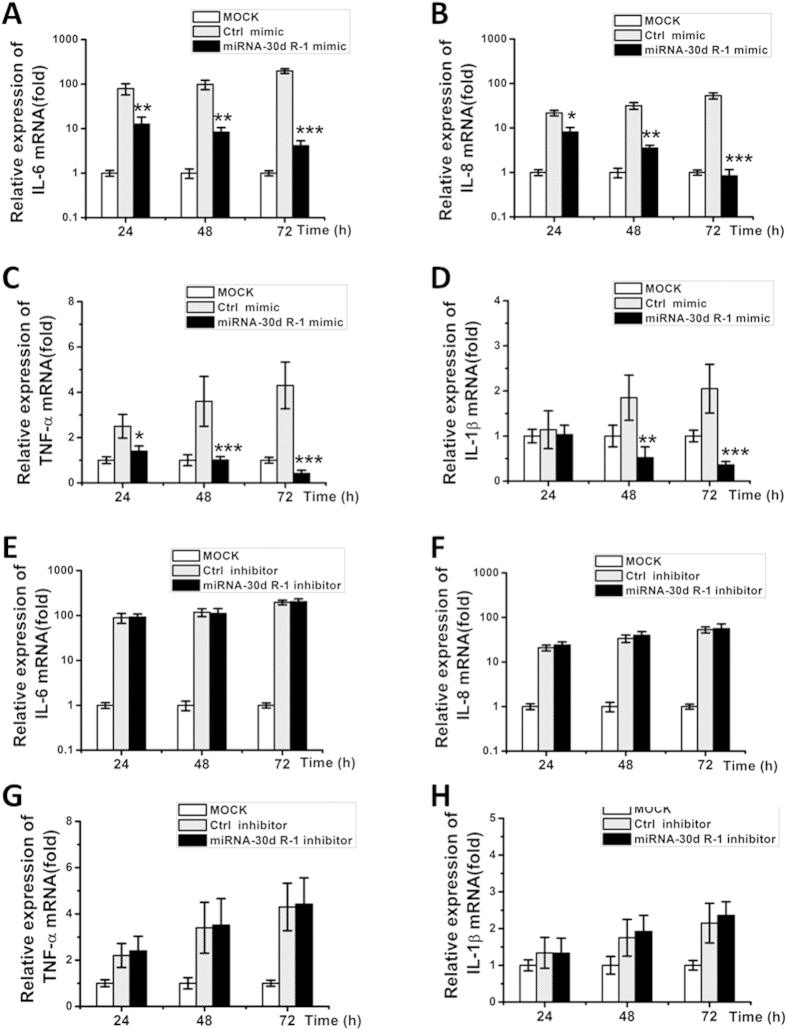
The suppressive effect of ssc-miR-30d_R-1 on pro-inflammatory cytokines.(A–D) indicate overexpression of the ssc-miR-30d_R-1 mimic and control mimic in PAMs. The ssc-miR-30d_R-1 mimic reduced mRNA levels of pro-inflammatory cytokines (IL-8, IL-6, TNF-α and IL-1β) in a time-dependent manner in PAM cells. (E–H) indicate ssc-miR-30d_R-1 inhibitor-enhanced mRNA levels of pro-inflammatory cytokines (IL-8, IL-6, TNF-α and IL-1β) in a time-dependent manner in PAM cells (F). PAM cells were transfected with mimics or inhibitors, followed by PRRSV infection (MOI = 0.1). Data are expressed as the mean ± standard deviation of three independent experiments. P values were calculated using a Student’s t test. *P < 0.05; **P < 0.01; ***P < 0.001. Similar results in MARC-145 cells are shown in Fig. S2.